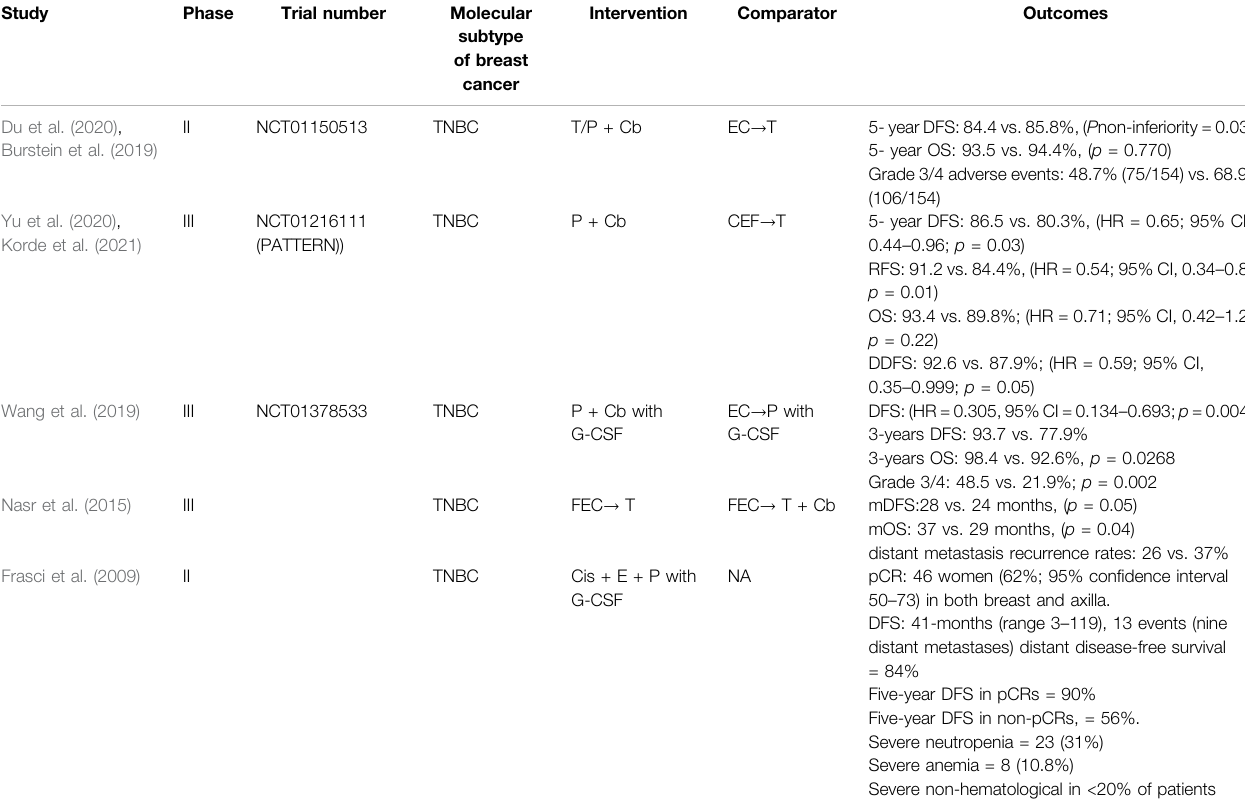
TABLE 2 | Summary of adjuvant studies with Pt derivatives and taxane combinations.